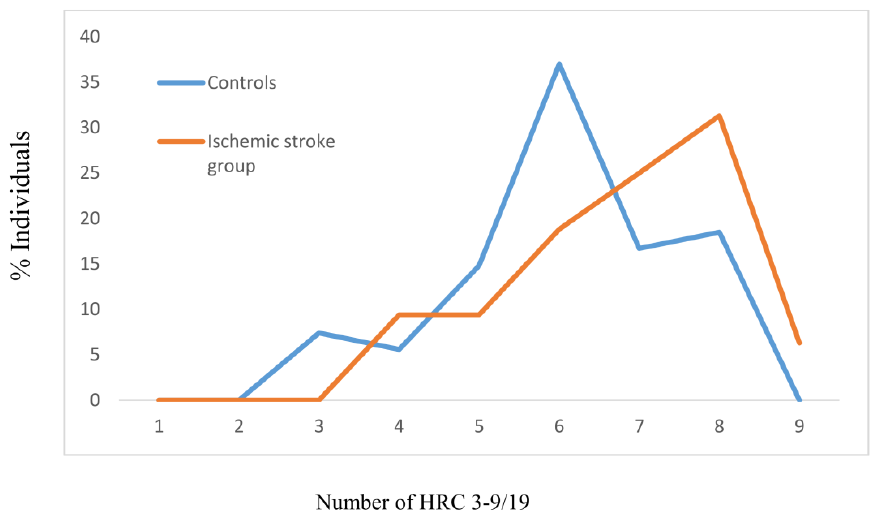
Figure 2. Frequencies of homozygous recessive characteristics (HRC) in controls and manifested ischemic stroke patients without hypertension. MV- mean value; SD- standard deviation; z - Mann Whitney U test; V- variability. Controls: N = 108, MV ± SD = 6.02 ± 1.40. Ischemic stroke group: N = 64, MV ± SD = 6.78 ± 1.40 ( z = −3.160, p = 0.002; Cohen’s d = 54.29%). V Controls = 23.26%, V Ischemic stroke group = 20.65%.